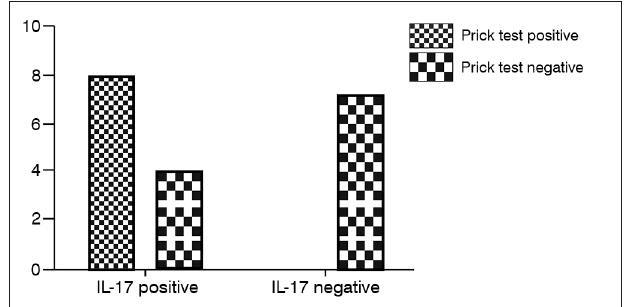
Graph 2. Expression of IL-17 and prick test result - The number of IL-17 positive cells were greater in nasal polyps of atopic patients than